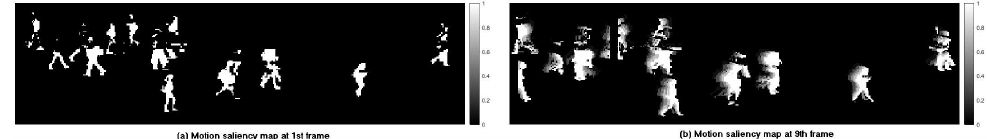
Figure 9. Sample output of Algorithm 1 using frames in Figure 8, deAtt = 60, and Γ =